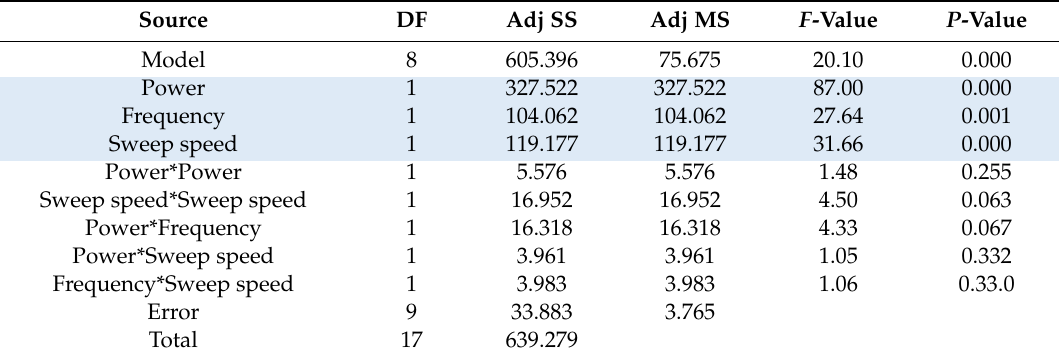
Table 8. ANOVA analysis of the free surface energy obtained in laser texturing.